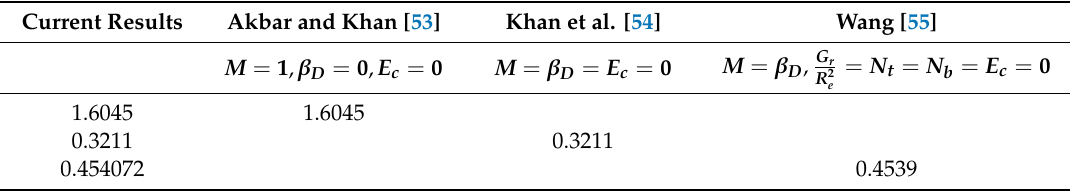
Table 2. Comparison of the current outcomes for Nusselt number with the previous investigations.